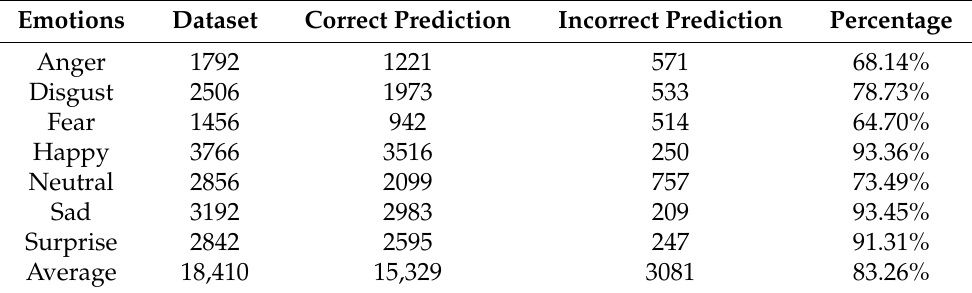
Table 8. Test result with prediction detail of Model 1 after 10